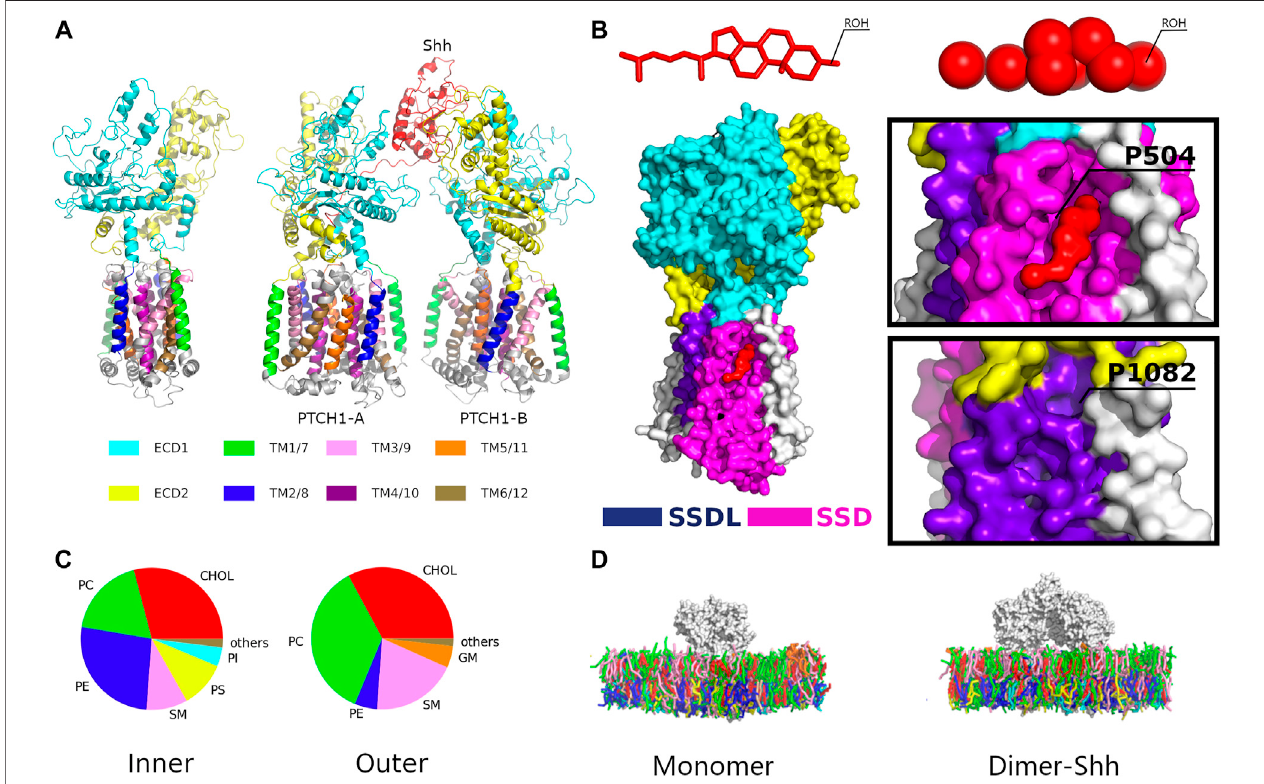
FIGURE 1 | The simulation system. (A) Structures of the PTCH1 monomer and dimer-Shh. (B) The locations of the SSD and SSDL sites with a close view of Cholesterol binding to the SSD pocket. (C) The lipid compositions of the outer and inner lea fl ets of the membrane model. Lipid types included are phosphatidylcholine (PC), phosphatidylethanolamine (PE), phosphatidylserine (PS), sphingomyelin (SM), phosphatidylinositol (PI), ganglioside (GM), Phosphatidic acid (PA), and cholesterol (CHOL). (D) The Martini CG models of PTCH1 monomer and dimer-Shh